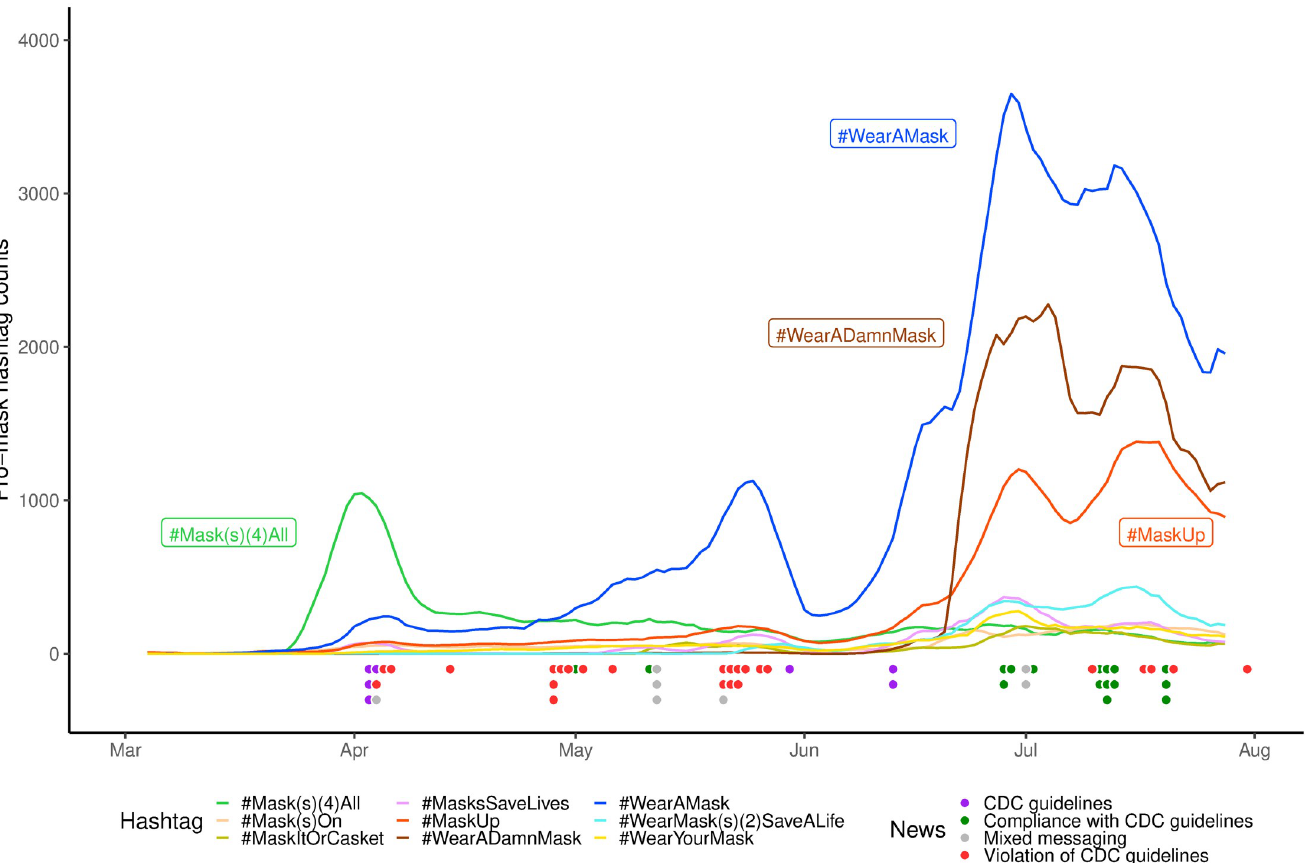
Fig 1. Trends of pro-mask hashtag uses on Twitter. This figure plots the 7-day moving averages of the daily rates of nine most popular pro-mask hashtags from early March to early August 2020. Along the timeline are shown news headlines in four categories: mask-related guidelines made by public health authority CDC, administrative actions compliant with the CDC guidelines, administrative violation of the CDC guidelines, and mixed messages from White House on masks.